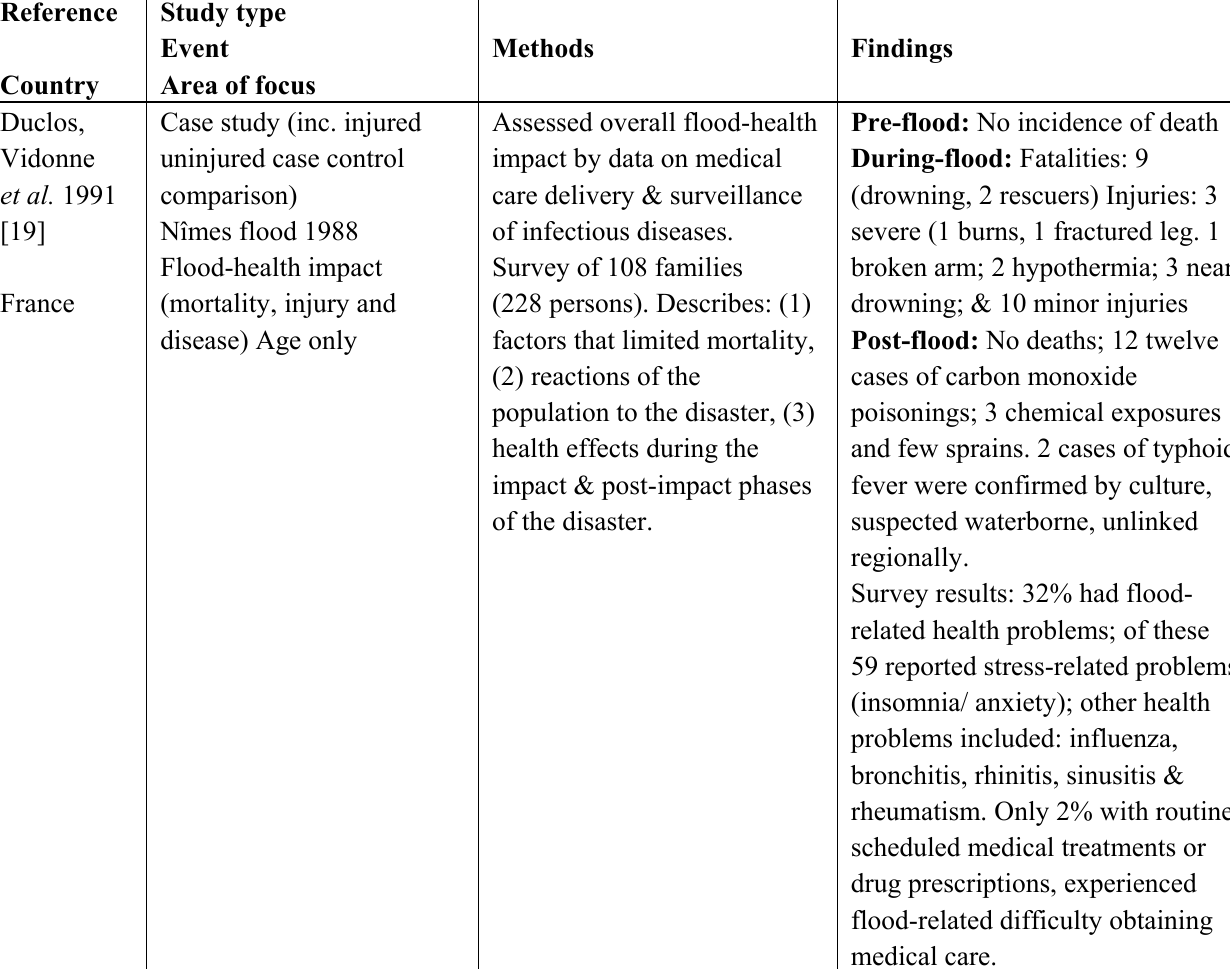
Table A3. Studies that address research Question 2: What are the health effects of floods when compared to un-flooded